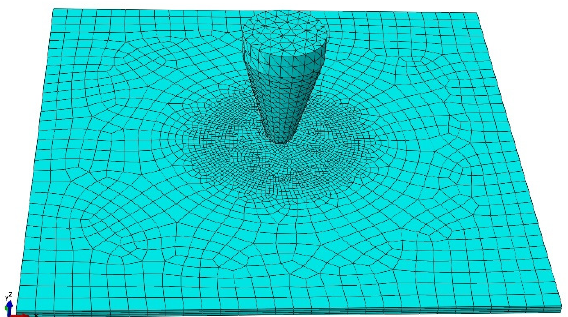
Figure 9. Mesh model of a single plate.